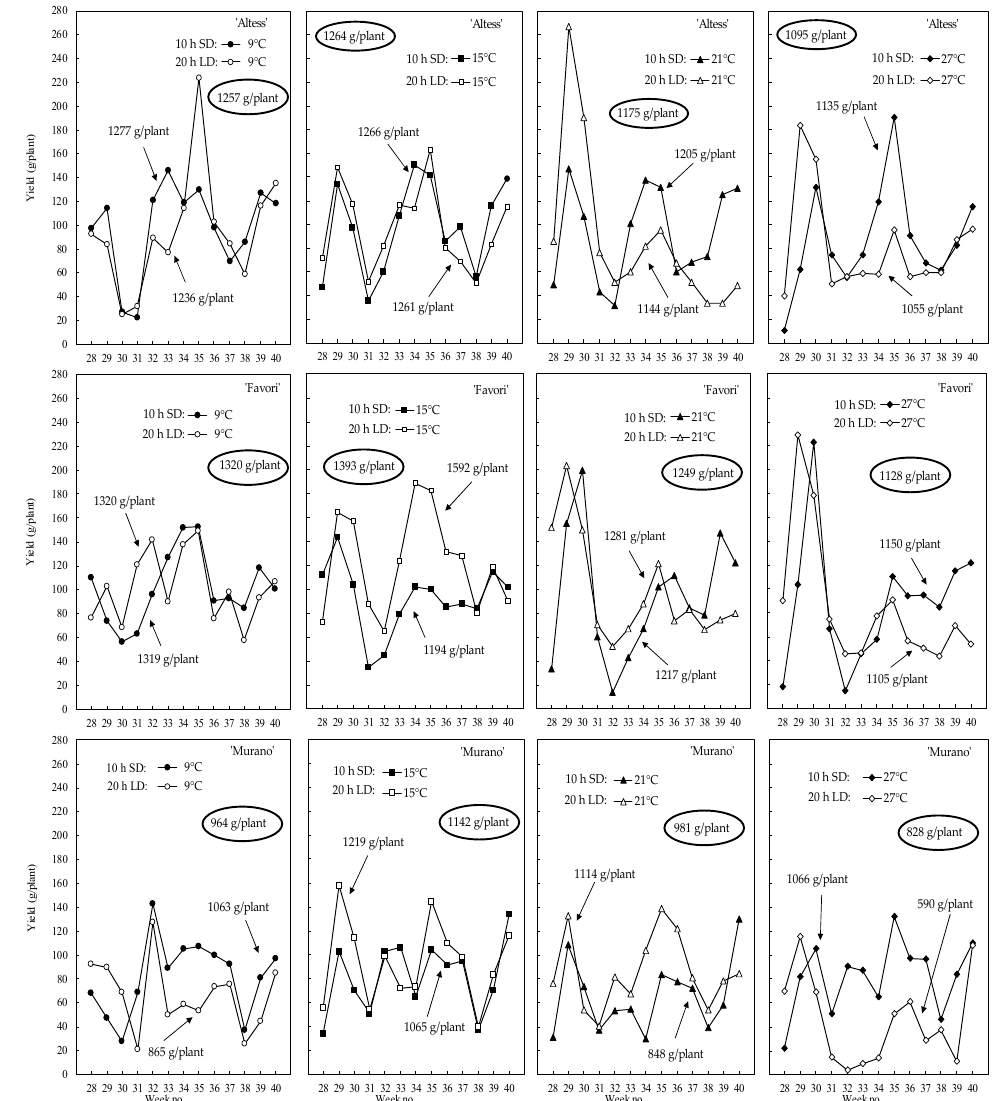
Figure 5. Time courses of weekly berry yield of three EB strawberry cultivars as affected by 4 weeks of preconditioning at temperatures of 9 °C, 15 °C, 21 °C, 27 °C and 10 h or 20 h photoperiods, as indicated, followed by further raising under natural outdoor conditions from 12 September until 24 October 2018. The plants were cropped in a plastic tunnel after overwintering in cold storage at − 1.5 °C from 24 October 2018 until 5 May 2019. The data are means of three replications with four plants each. Values in the ovals represent the mean yield for both photoperiods at each temperature .